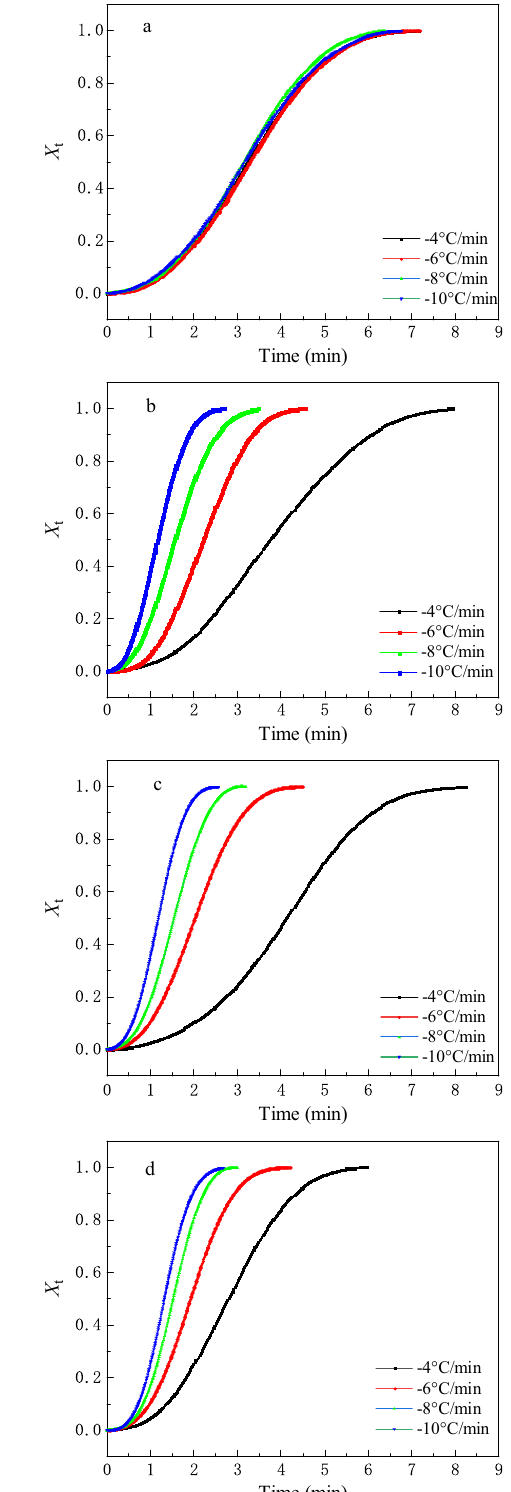
Figure 3: Plots of X t versus t at cooling rates of − 4, − 6, − 8, and − 10°C · min − 1 for ( a ) AB, ( b ) ABCa - m 5 , ( c ) ABCa - m 11 , and ( d ) ABCa - n 11 m 5